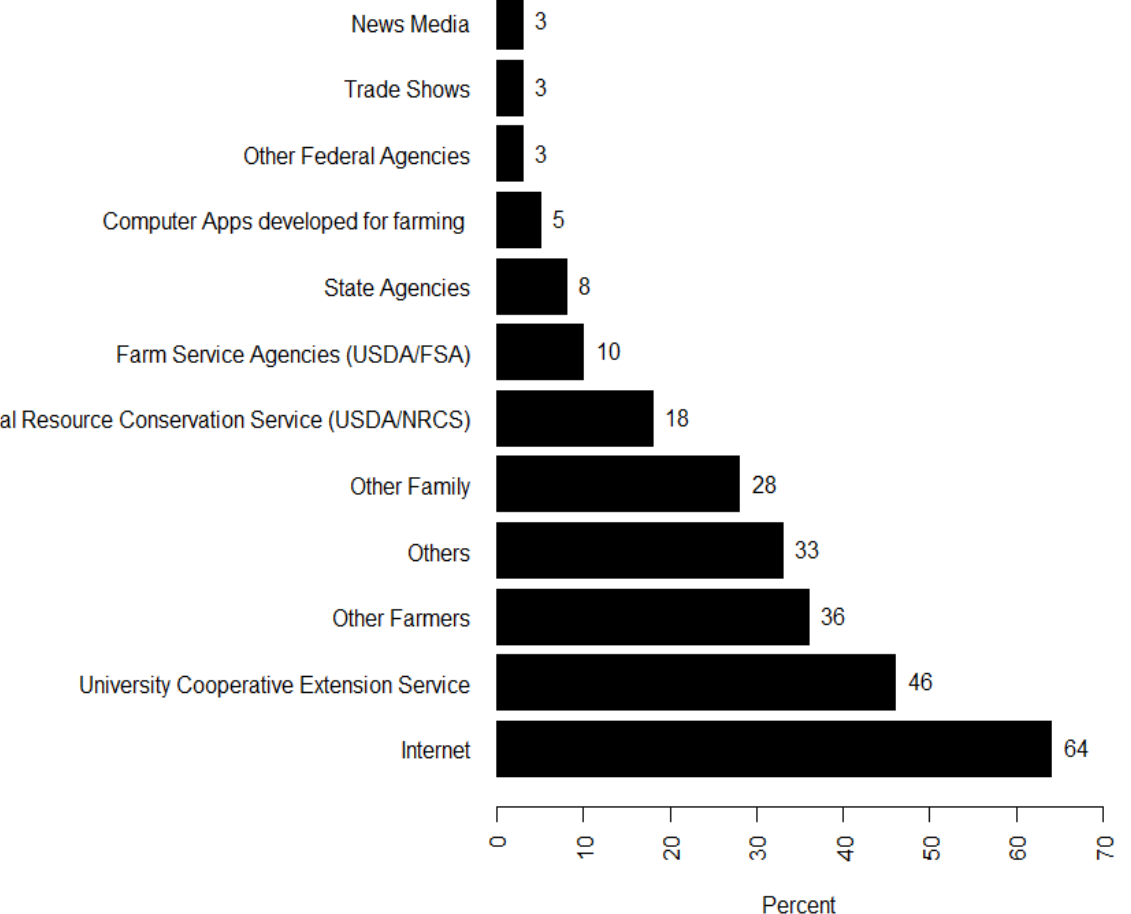
Figure 3. Resources used by survey participants to make decisions about their farming operations ( n = 40). The internet category excludes web-based resources that fall under another listed category.